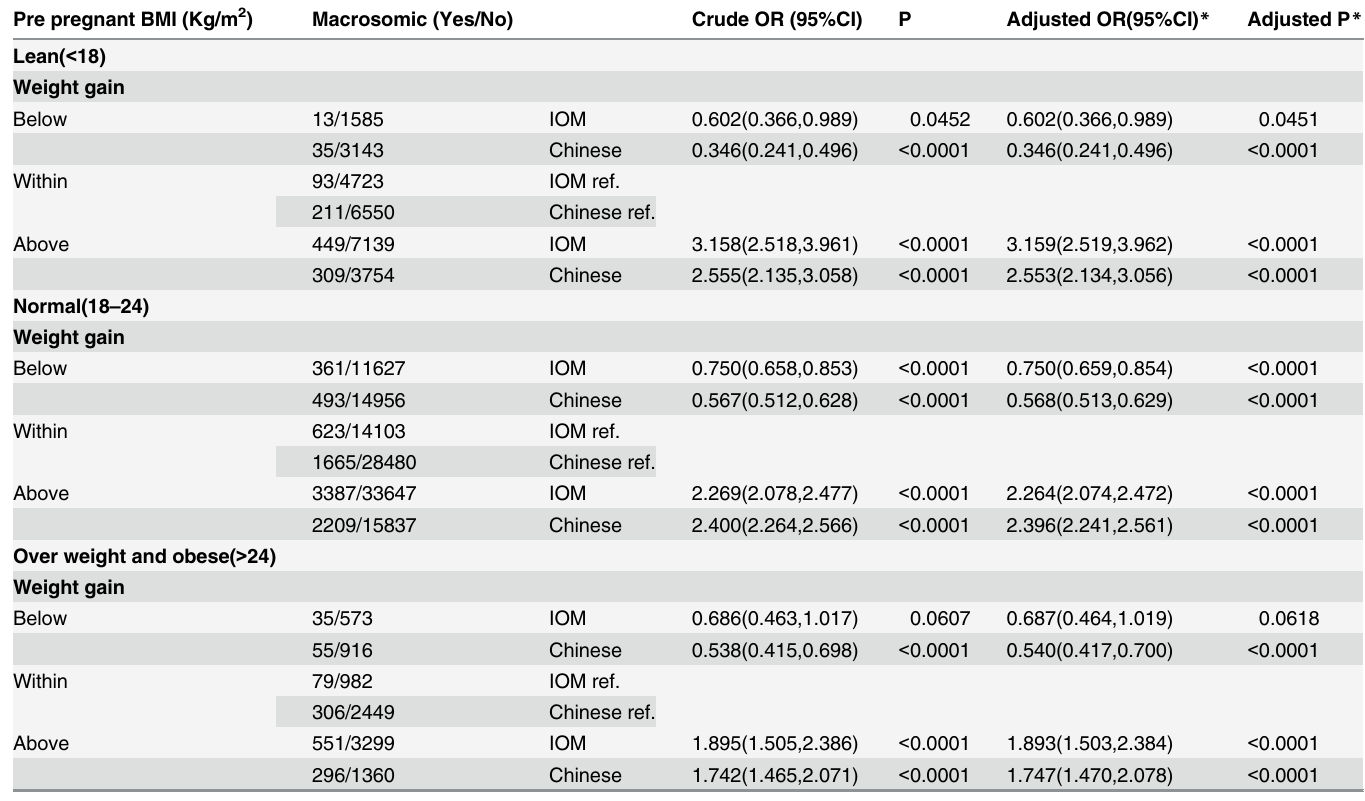
Table 5. ORs for macrosomic by weight gain and pre pregnant BMI.